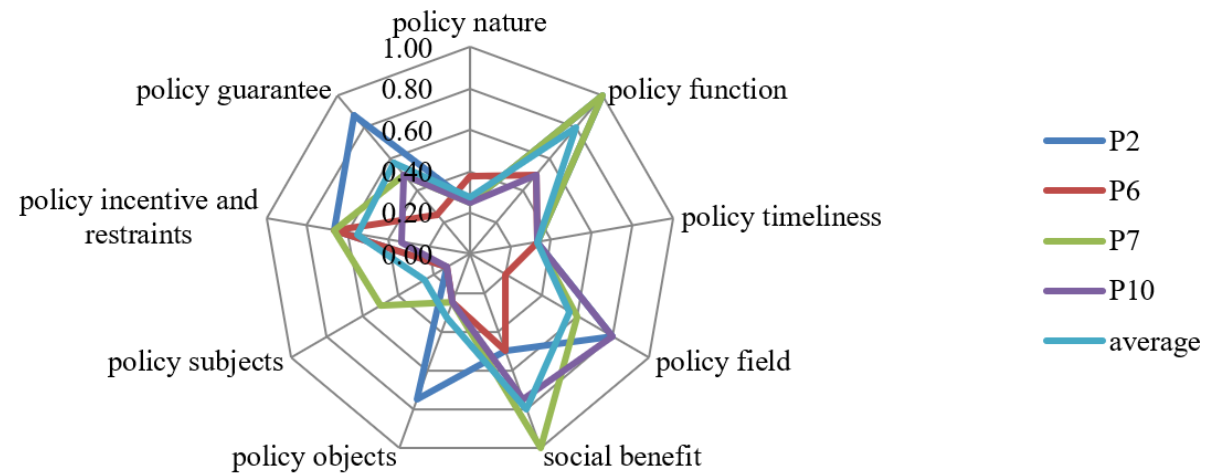
Figure 12. Radar chart comparison of P2, P6, P7 and P10.